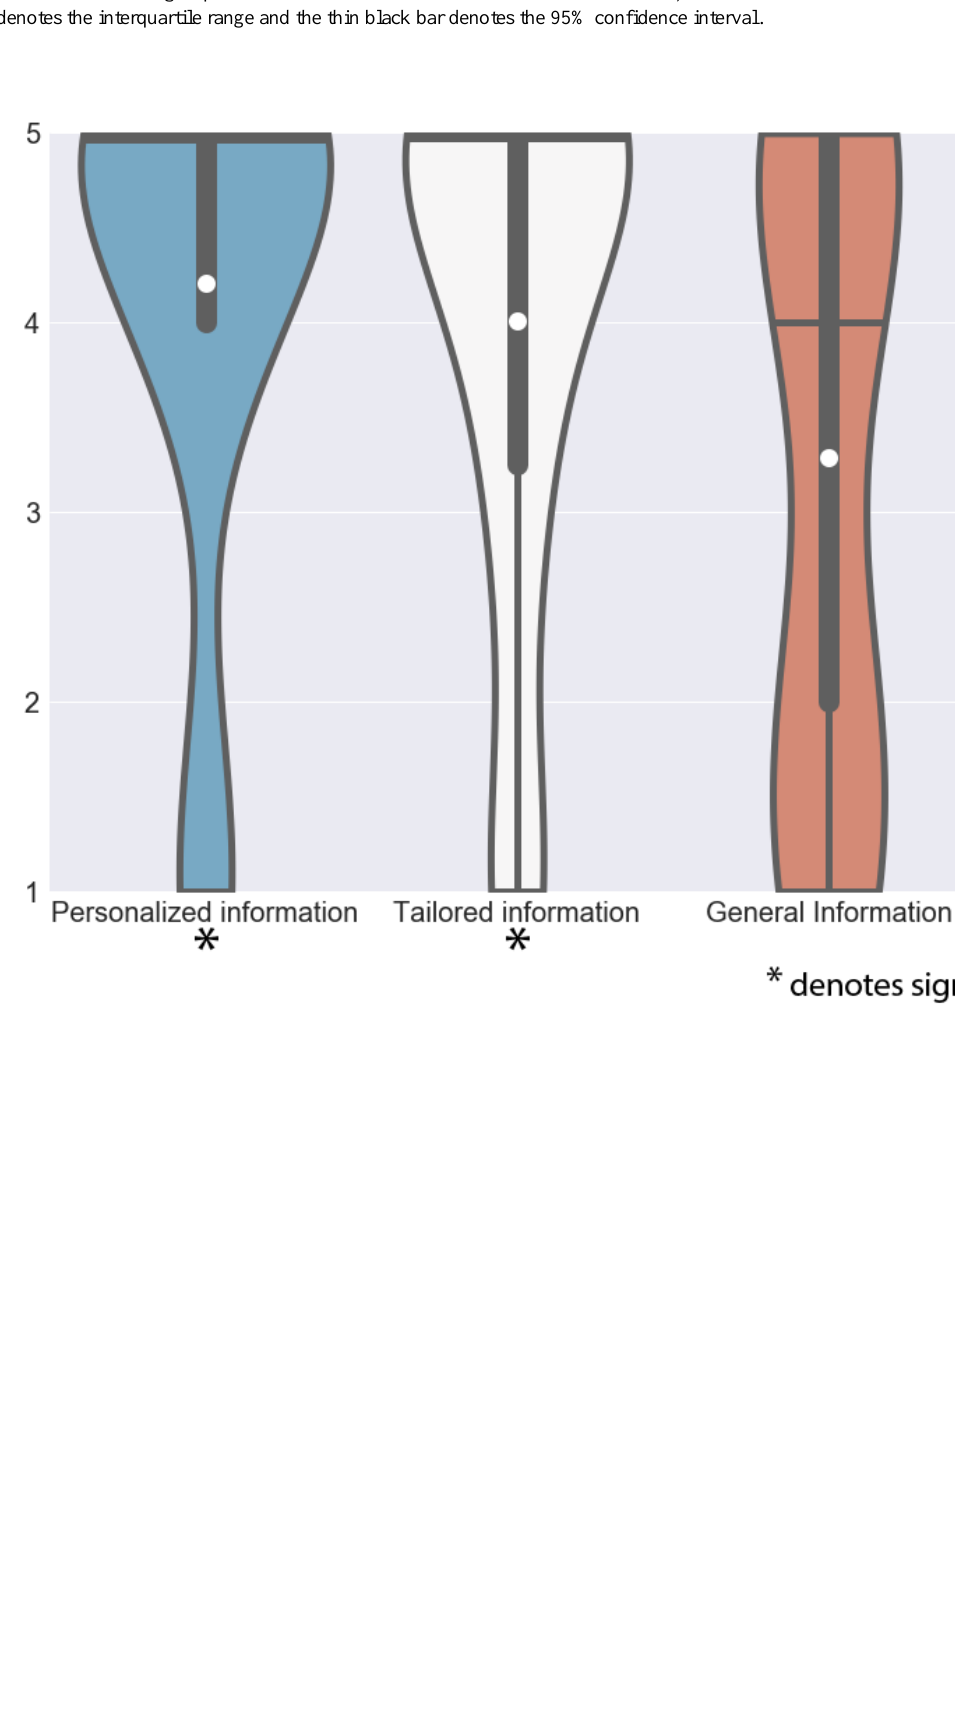
Figure 4. Scores of features in the group of Information. The white dot denotes the mean value, the horizontal black bar denotes the median value, the thick black bar denotes the interquartile range and the thin black bar denotes the 95% confidence